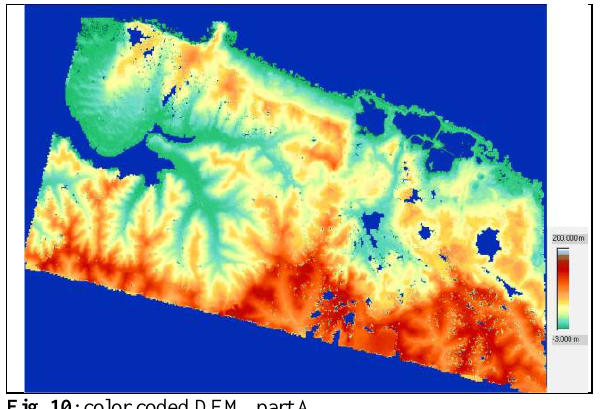
Fig. 10 : color coded DEM, part A